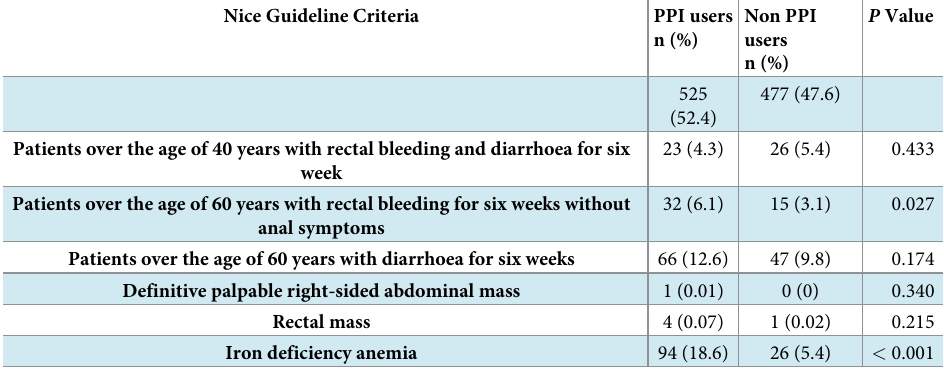
Table 2. Prevalence of high risk symptoms according NICE Guideline criteria by PPI use.